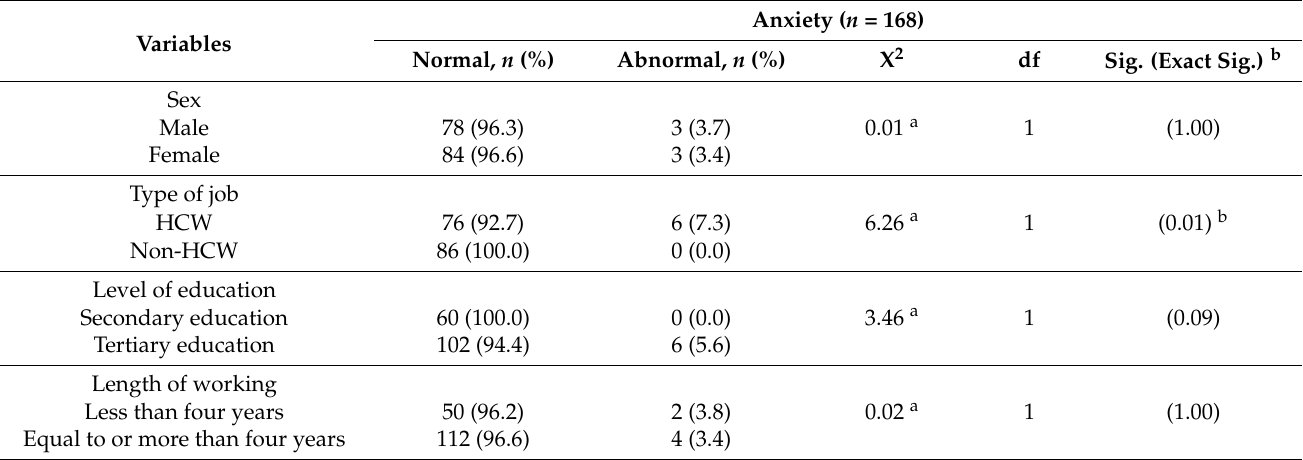
Table 8. Association between anxiety and sociodemographic and occupational information